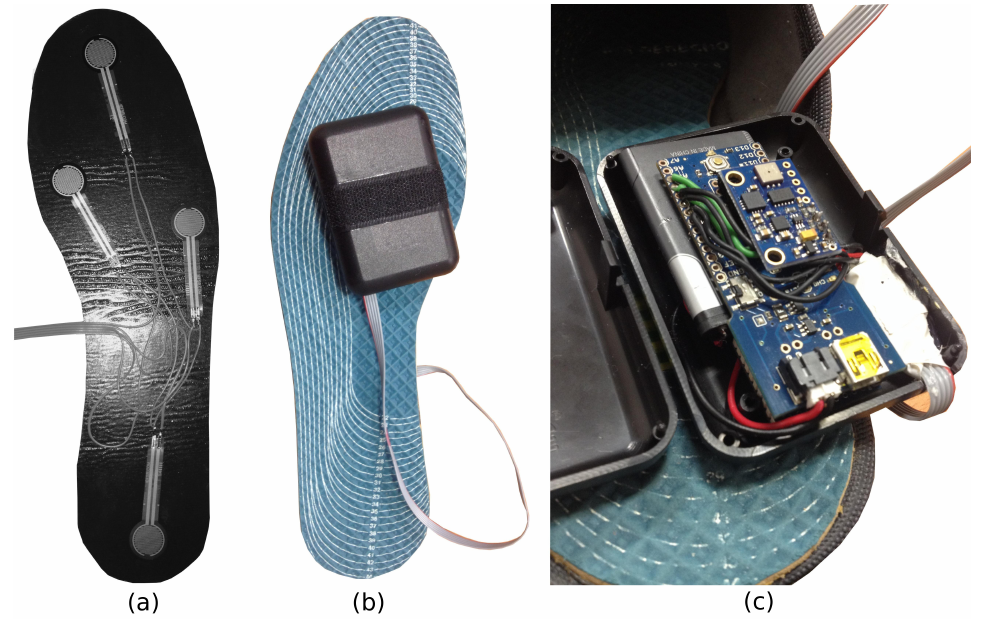
Figure 2. Insole hardware prototype. Arrangement of FSR sensors on the insole ( a ). Final prototype ( b ). Arduino Fio + 9DOF IMU (GY-80) + 3.7V LiPO batt. + Bluetooth module WLS125E1P ( c